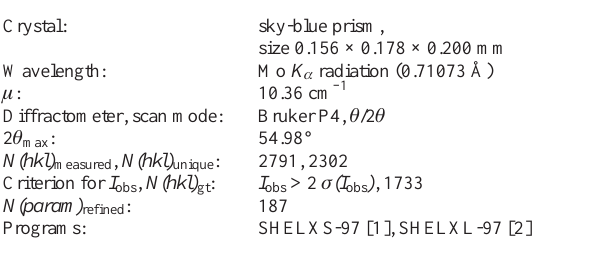
Table 1. Data collection and handling.